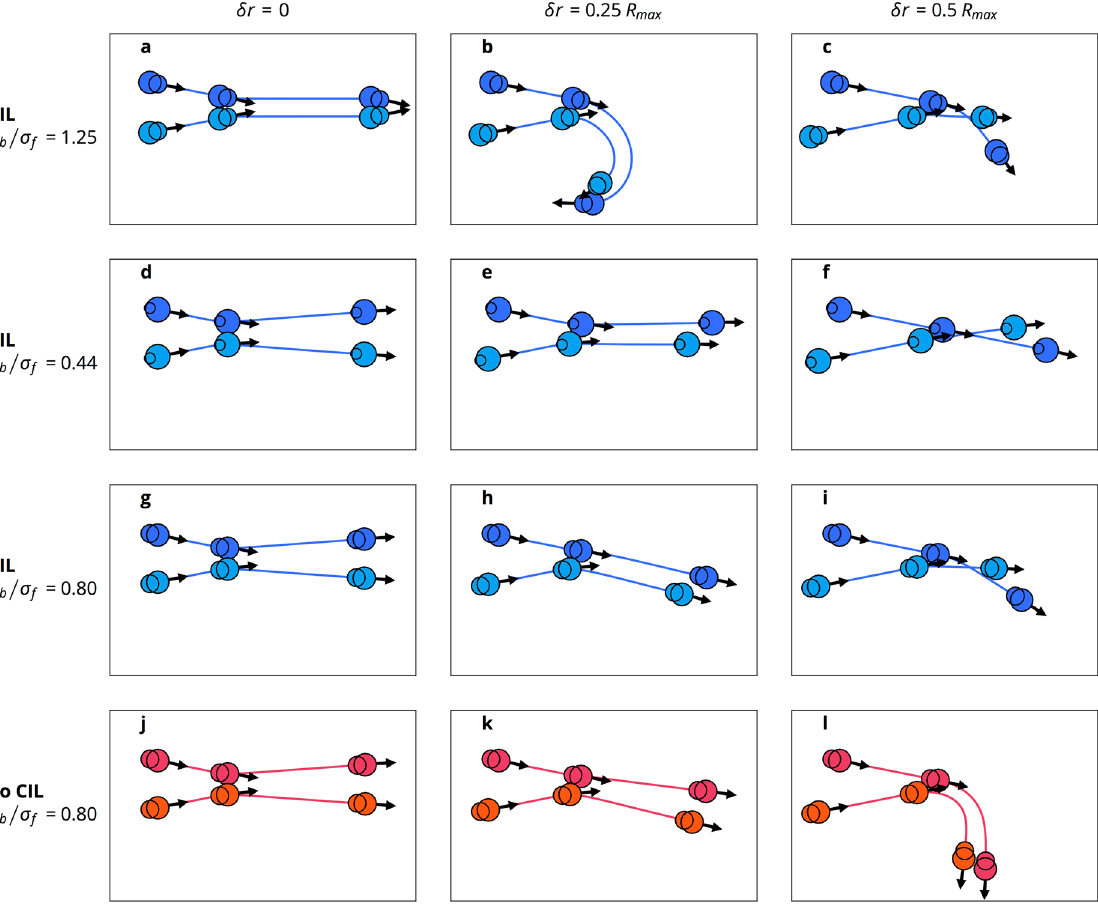
Figure 8. Binary collisions. Trajectories of two cells colliding with a collision angle of θ in = π /8. Arrows indicate the migration forces. The cells are shown at their initial position, during the collision, and at the end of the simulation. All trajectories depict the same duration of